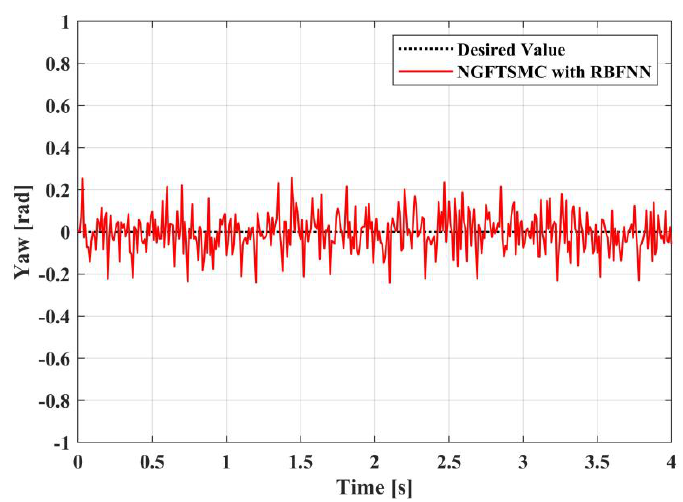
Figure 21. The experimental results in pitch angel.